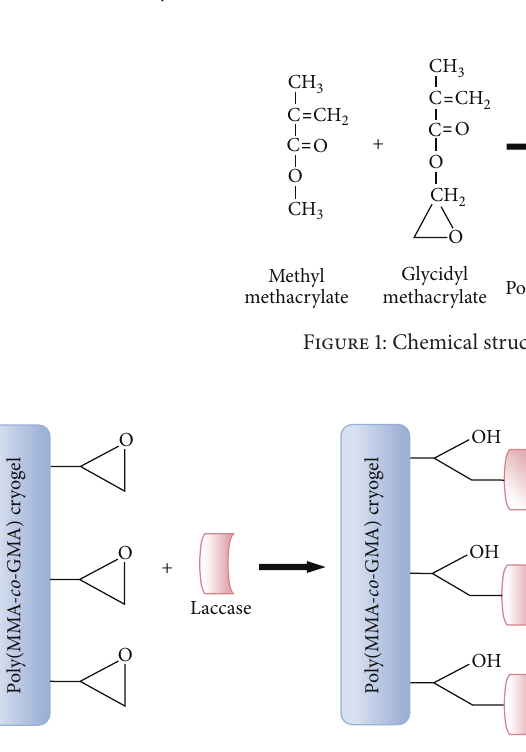
Figure 2: Schematic presentation of the immobilization of laccase onto cryogel structure.